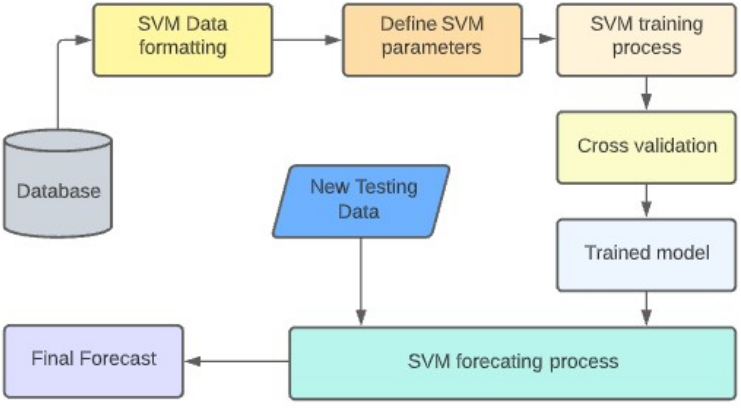
Figure 3. SVM algorithm flowchart .